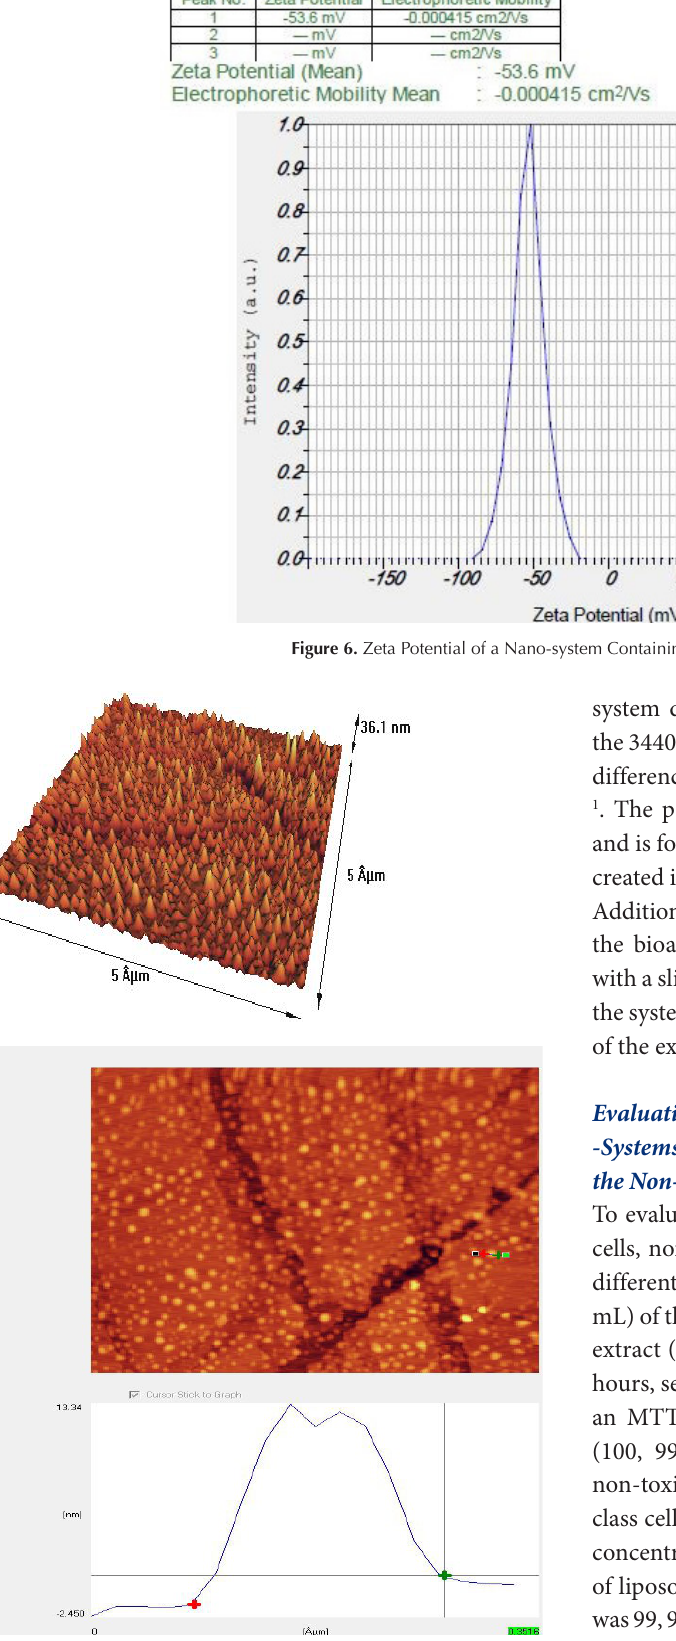
Figure 7. The Obtained Images From the Examinations of Nano-lipids Containing the Licorice Extract With an AFM Microscope. Note . AFM: Atomic force